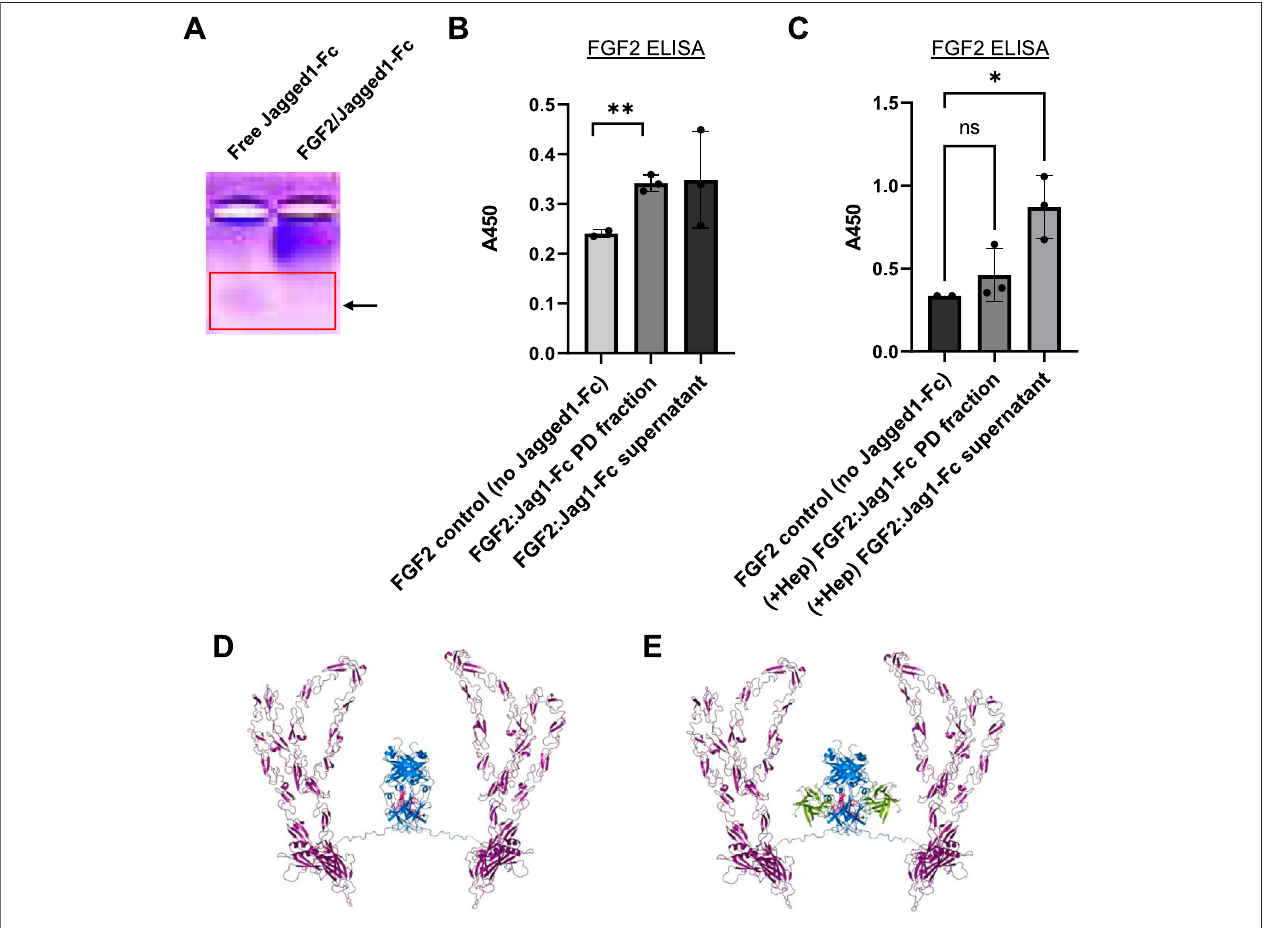
FIGURE 6 | Generation of recombinant human FGF2/Jagged1-Fc complexes. (A) Native isoelectric focusing gel to detect protein complexes. Lanes: 1) free Jagged1-Fcfusionprotein(alone);2)FGF2/Jagged1-Fccomplex.Redbox:notethattheproteinbandexpectedforfreeJagged1-FcIgGisabsentintheright-handlane withFGF2/Jagged1-Fccomplexes.Thus,complexationwithFGF2retardsthemigrationofJagged1-Fc. (B) ELISAdataforFGF2toassaycomplexformation.FGF2was incubated either alone or with Jagged1-Fc-His, followed by addition of anti-His-biotin. Streptavidin-agarose was used to pulldown complexes and 0.5% Sodium deoxycholate was used to dissociate protein-protein interactions prior to FGF2 ELISA. Data in (B,C) are mean ± SD and were analyzed by one-way ANOVA with post- hoc comparisons. n = two to three experimental replicates. ** p < 0.01. (C) Addition of excess heparin (50 μ g) during initial incubation of FGF2 with Jagged-Fc-His prevents complexformation. ** p < 0.01. (D) Ribbon representation ofmodeled Jagged1-Fc fusionprotein homodimer. (E) Ribbonrepresentation ofmodeled Jagged1- Fc fusion in complex with